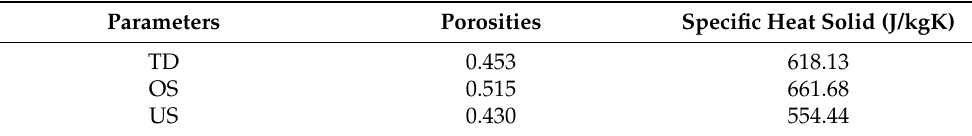
Table 4. Specific heat of each lot corrected for the solid